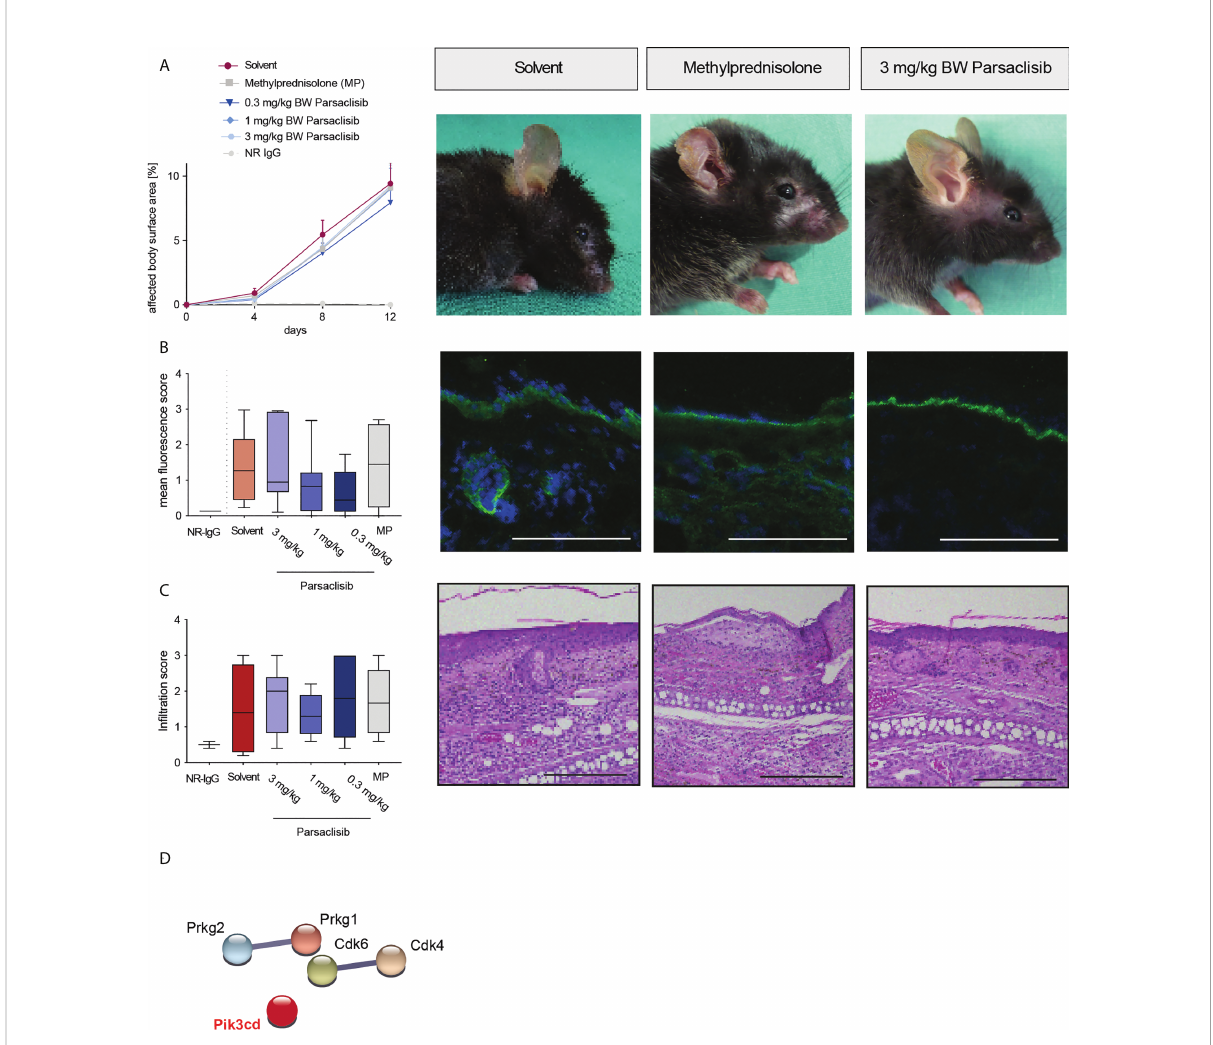
FIGURE 5 Parsaclisib does not affect antibody transfer-induced EBA. C57BL/6J mice were injected every other day with rabbit anti-mCOL vWFA2 IgG (n=17/ group) or normal rabbit (NR) IgG (n=5) for a total of 12 days. Administration of methylprednisolone (MP), solvent or parsaclisib (0.3, 1, or 3 mg/ kg) was initiated on day 0 of the experiment and continued until day 11. (A) Percentage of affected body surface area was measured at days, 0, 4, 8 and 12. Representative clinical images of the mice at day 12. Data are shown as mean ± SD. (B) To visualize IgG binding to the dermal- epidermal junction, ear skin was stained for anti-mouse IgG (green) and nuclei (DAPI, blue). Representative direct IF pictures and mean fl uorescent intensity of IgG binding. (C) Representative H&E-stained ear skin at the end of the experiment. The cumulative histological score index (amount of skin in fi ltration, epidermal thickening and split formation at the DEJ) was analyzed in lesional back skin. (B, C) , data are shown as Tukey ’ s box-and-whisker plots. ANOVA on ranks (Kruskal-Wallis) was applied followed by a Dunn´s multiple comparison test. (D) PamGene kinome analysis of lesional skin treated with solvent or 3 mg/ml parsaclisib (n=3), respectively. String database analysis of kinases that are modulated by parsaclisib; contrasting kinase activation in lesional skin from solvent- to parsaclisib-treated mice. STRING interaction modules are shown at the medium con fi dence level. Thickness of the lines indicates the strength of the predicted interaction. Colors of kinases are randomly selected. Differently activated kinases that did not have any connections to other kinases were excluded from the networks, Scale bar=100